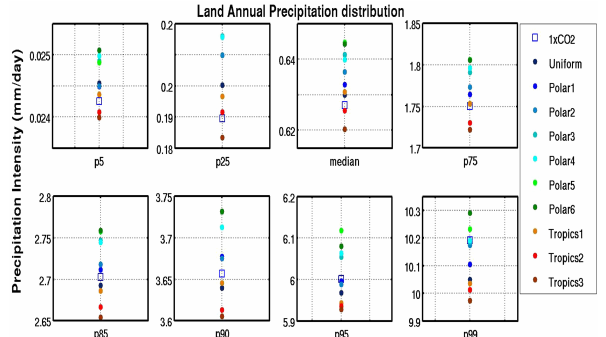
Figure 11. Percentile values (p5, p25, median, p75, p85, p90, p95 and p99) of precipitation intensity over Land. There is a monotonic increase in precipitation for all percentile values as the maximum concentration of aerosols over poles increases. Grid-level monthly mean precipitation over all land points are used to calculate the per- centile values.The last 30 years of 60-year simulations are used for the statistics.